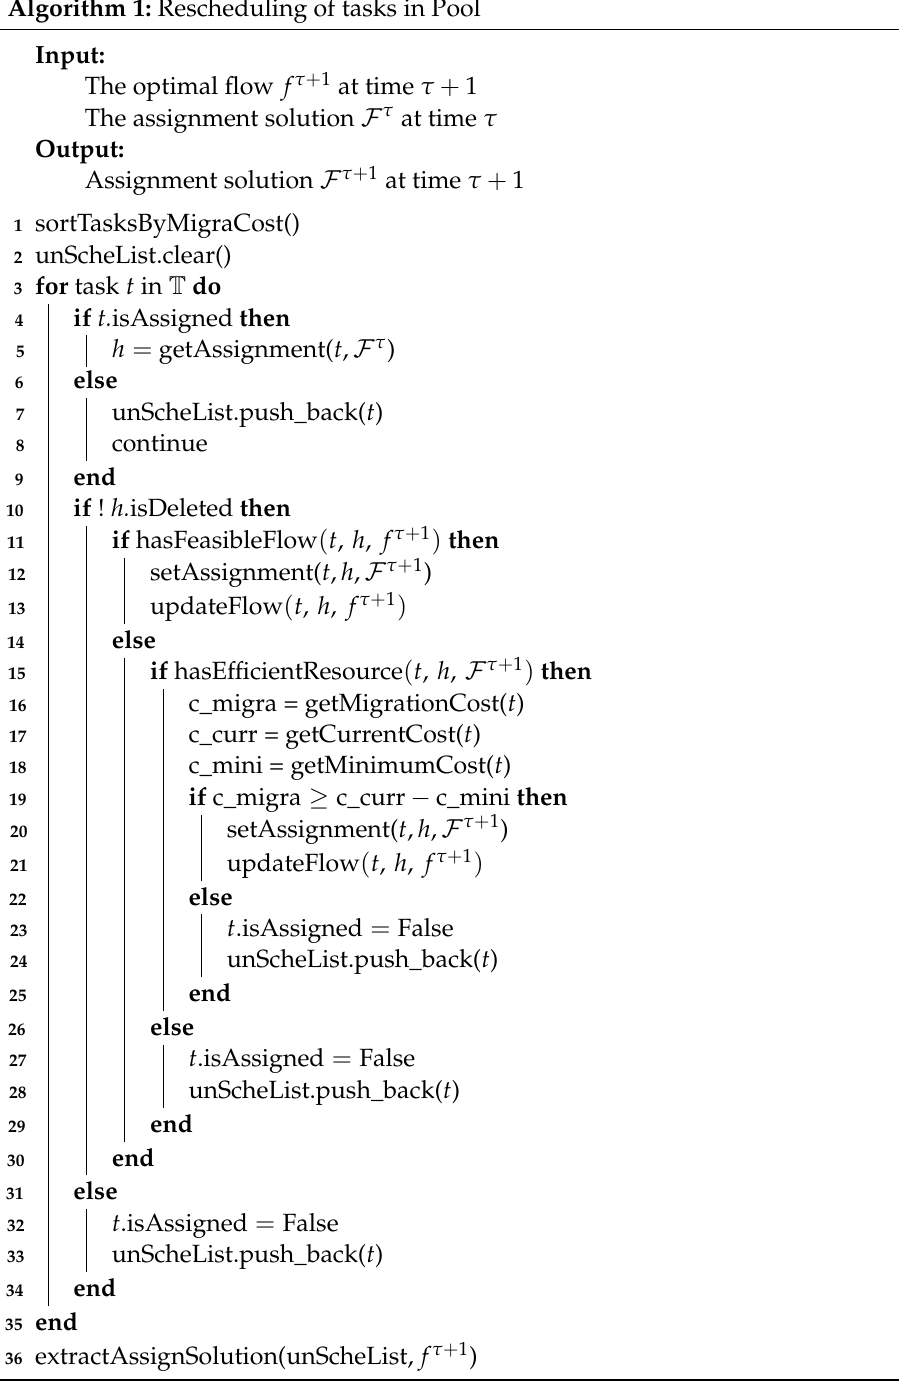
Algorithm 1: Rescheduling of tasks in